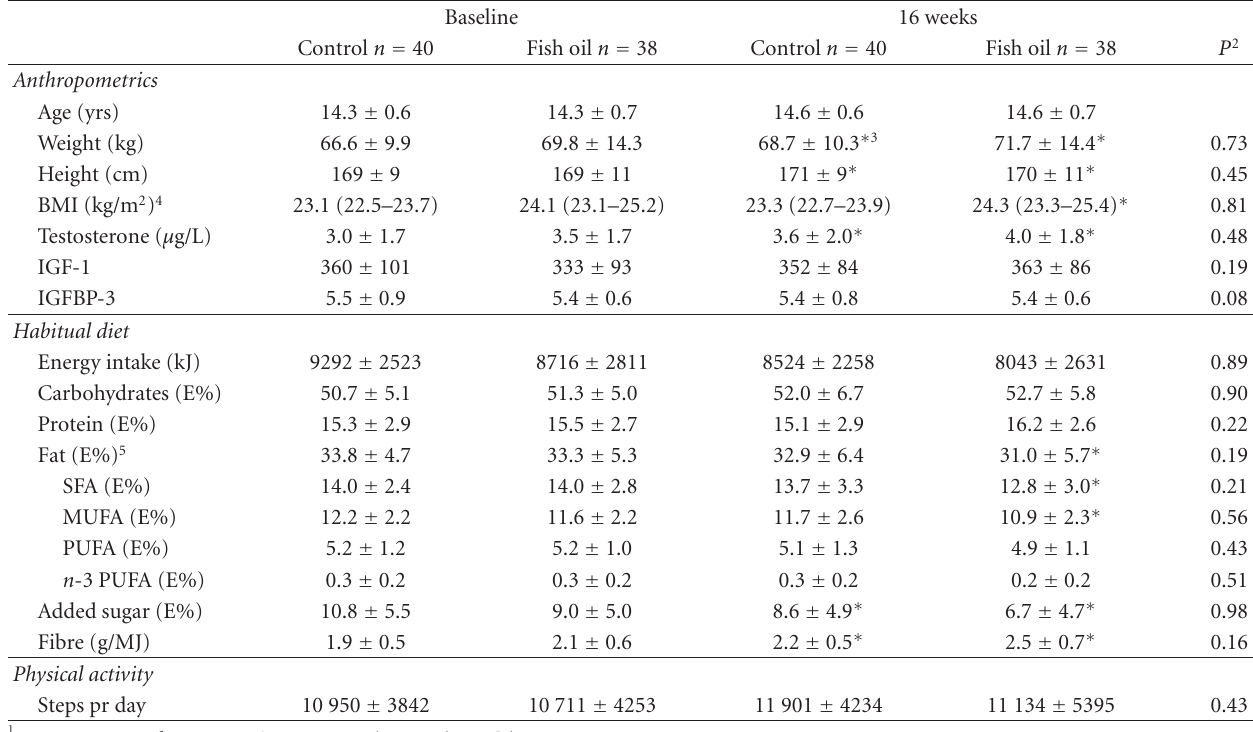
Table 1: Anthropometrics, habitual diet, and exercise 1 .